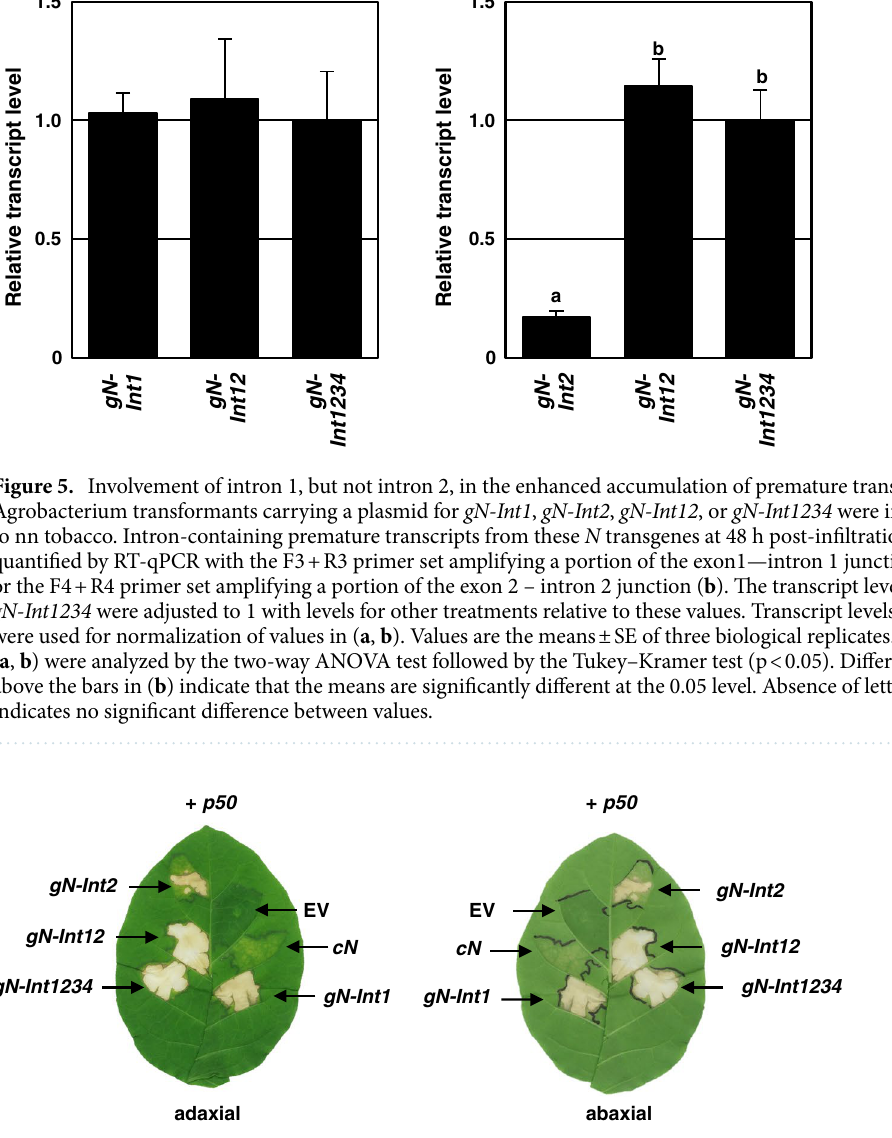
Figure 6. Effects of introns 1 and 2 on p50-triggered, N-mediated cell death in nn tobacco. Agrobacterium transformants carrying the indicated N transgene were infiltrated with those carrying p50 into nn tobacco. As a control, agrobacteria carrying the empty vector (EV) were used. Representative photos of an adaxial (left) and abaxial (right) side from an infiltrated leaf at 11 dpi are